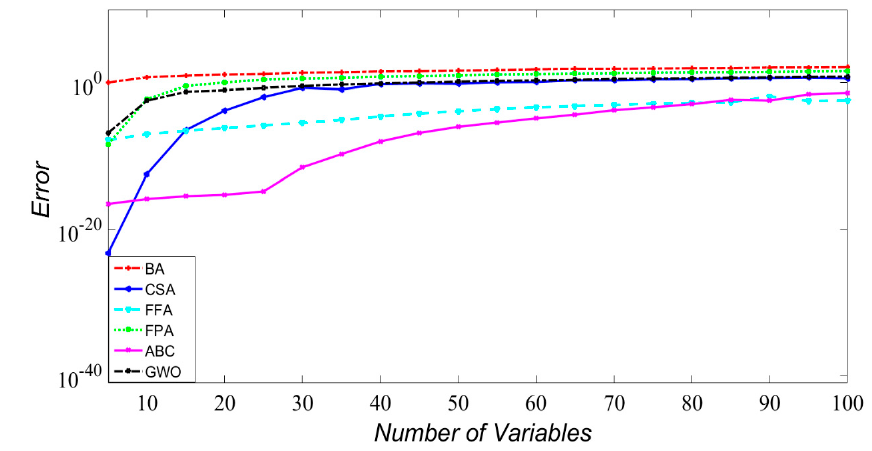
7 ). Algorithms 2017 , 10 , 120